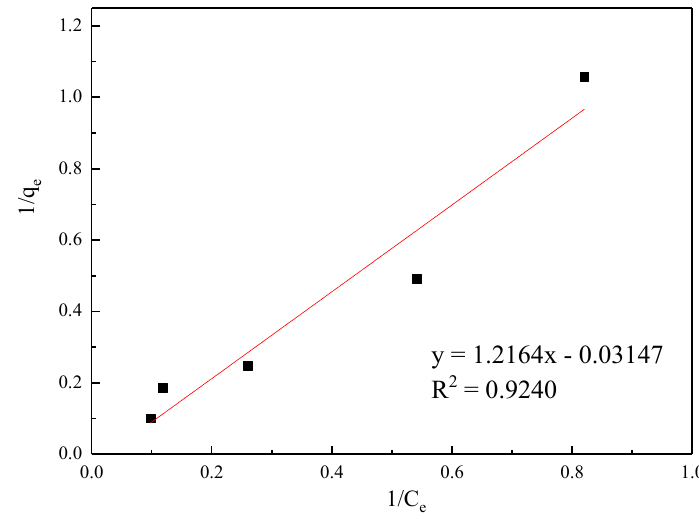
Figure 14. Linear regression of the Langmuir isotherm model (298 K).